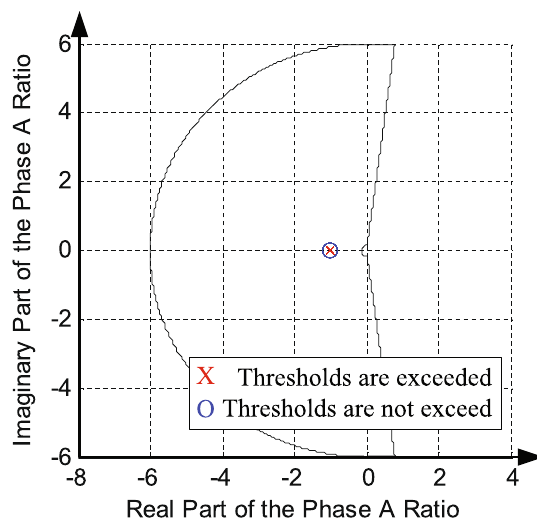
Fig. 12 Three phase currents and voltages of event 3: external bolted fault, grid-connected mode